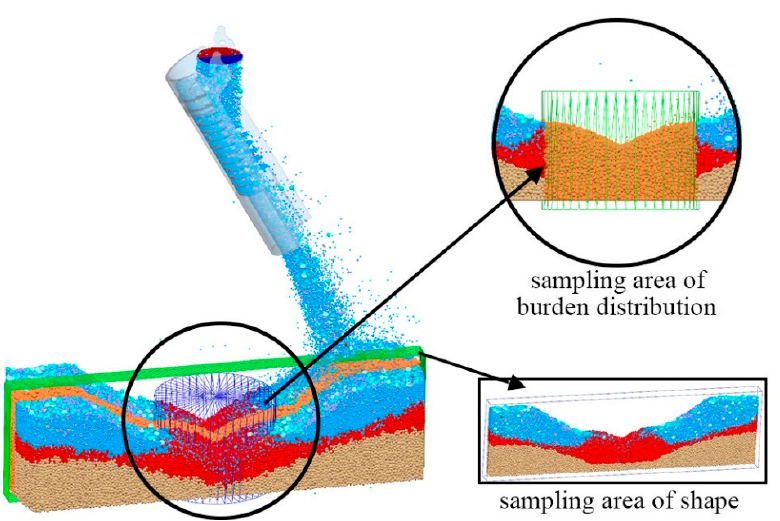
Figure 6. The sampling area diagram of data analysis.